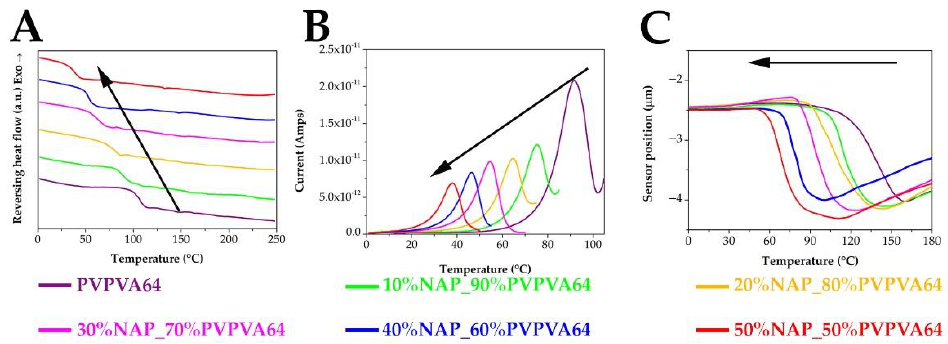
Figure 6. Summary of the MDSC ( A ), TSDC ( B ), and µ TA ( C ) results for determining T g . (The black arrows indicate the direction of the decreasing tendency in the T g values).